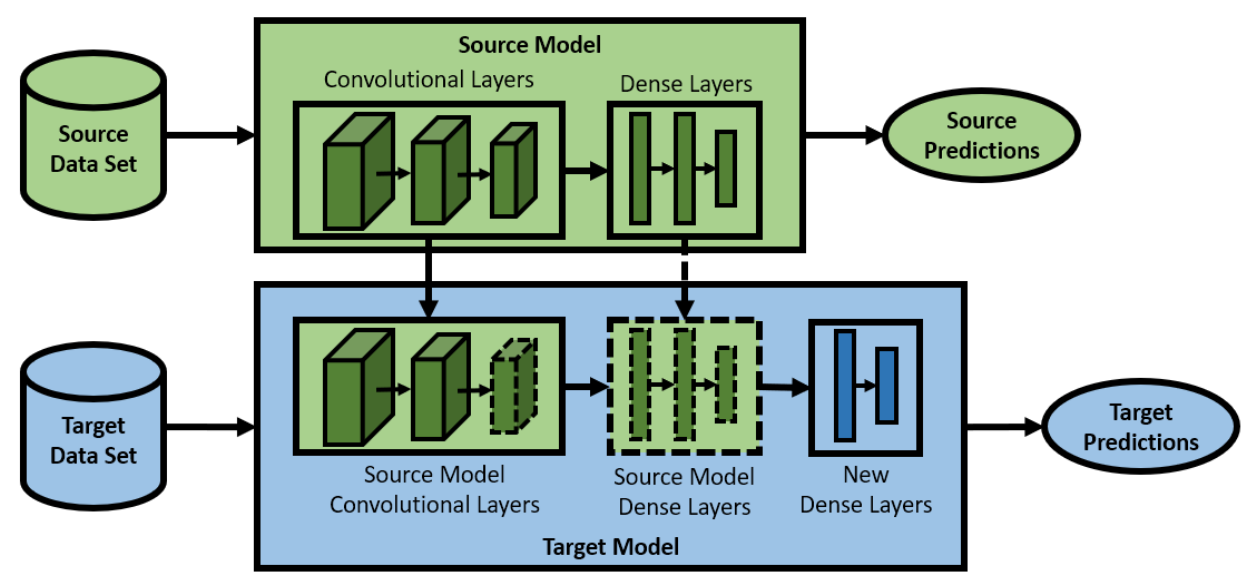
Figure 3. General transfer learning architecture; example optional elements have a dashed outline.